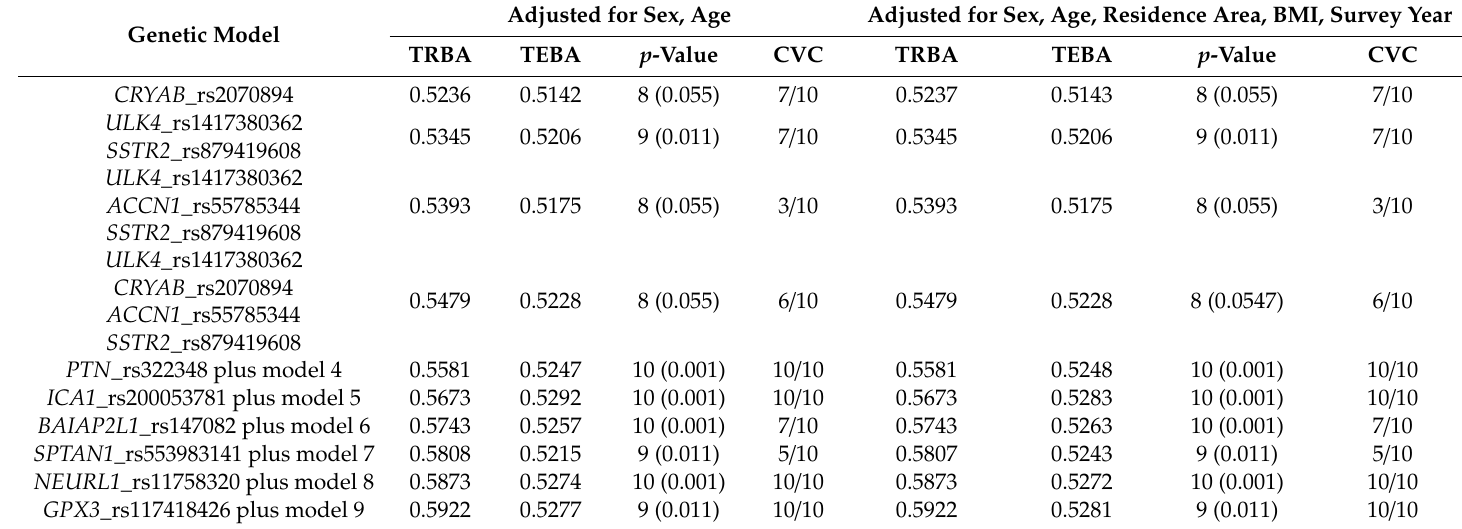
Table 3. Generalized multifactor dimensionality reduction (GMDR) results of multi-locus interaction with genes related to age-related cataracts. Genetic